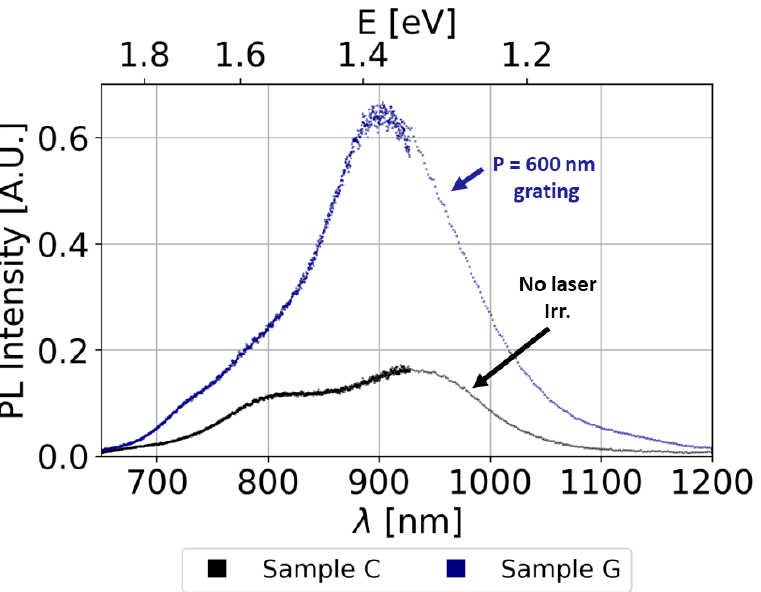
Figure 3. PL spectra of SiO x samples after high-temperature annealing without hydrogen passivation. A significant enhancement of the PL due to the periodic structuring is measurable. The PL intensity is shown in uncalibrated units but scaled identically in all measurements. Table 2. Results of PL measurements: area fraction denotes the integrated area relative to that of sample D. λ i (I = 1,2,3) denote positions of three Gaussians fitted to each spectrum, and f i their relative area fraction. For each sample, it is indicated whether hydrogen passivation was performed. The structure period resulting from laser irradiation is indicated for each sample. “No Irr.” means that no laser irradiation was carried out.